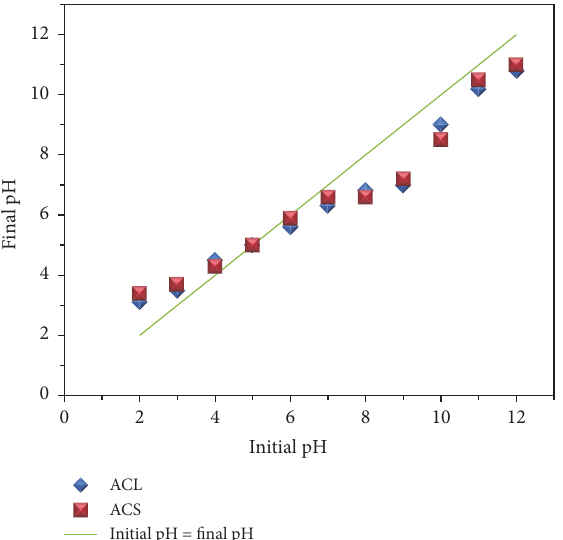
Figure 3: Determination of pH ZPC of ACL and ACS samples ( 𝑇 = 25 ∘ C).